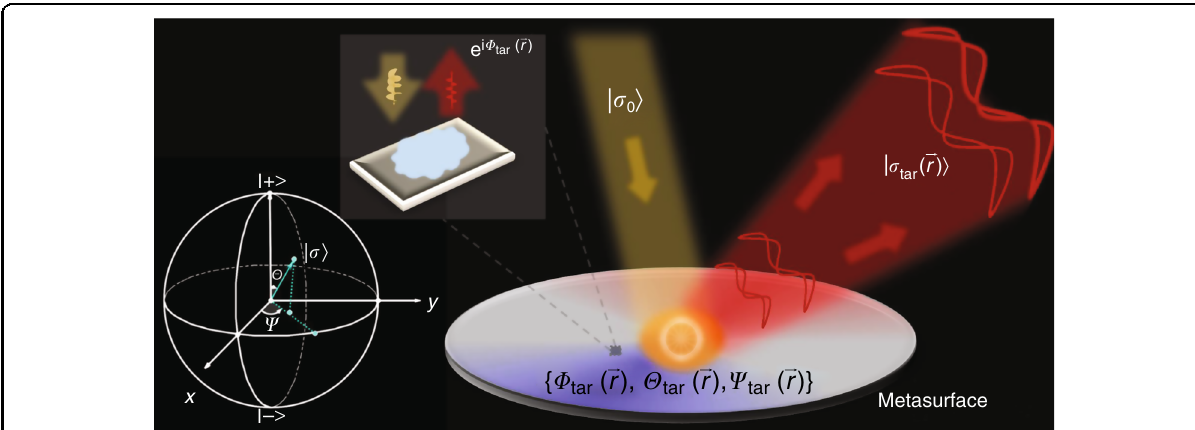
Fig. 1 Schematic of generating arbitrary VOFs with metasurfaces. A speci fi cally designed meta-atom can re fl ect normally incident light with polarization σ 0 j i (described by a point ð Θ 0 ; Ψ 0 Þ on Poincare ’ s sphere) to light with a target polarization σ tar j i (described by a point ð Θ tar ; Ψ tar Þ on Poincare ’ s sphere) with a desired phase Φ tar . Using a set of meta-atoms with different Φ tar and f Θ tar ; Ψ tar g to form a metasurface and illuminating it by normally incident light with polarization σ 0 j i , a VOF can be generated with the wavefront determined by Φ tar ð ~ r Þ and the polarization distribution determined by f Θ tar ð ~ r Þ ; Ψ tar ð ~ r Þg on the designed